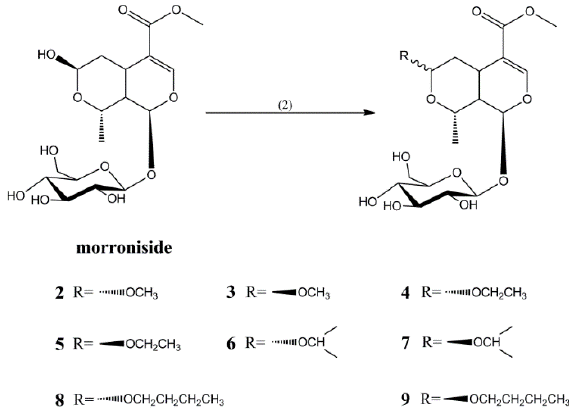
Figure 2. Synthesis of Compounds 2 – 9 . (2) RH, concentrated nitric acid, r.t., 30 min.